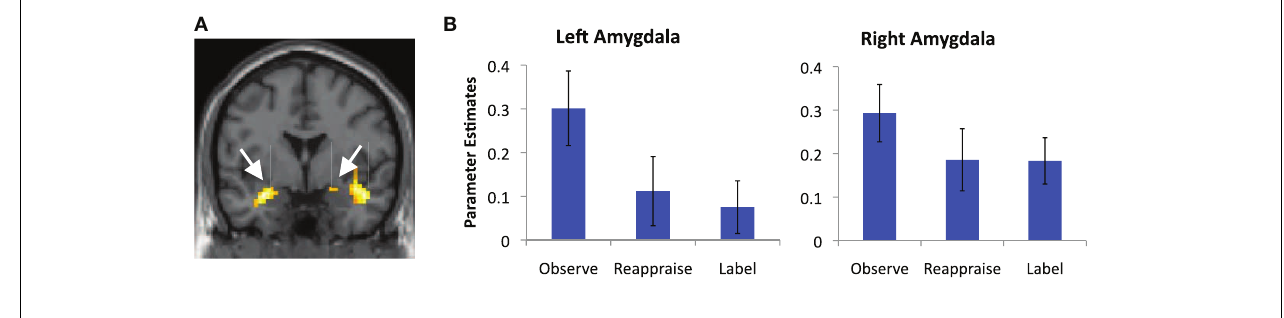
FIGURE 5 | Amygdala reductions. (A) Magnetic resonance image showing common regions of bilateral amygdala de-activation during affect labeling and reappraisal relative to passive observation; and (B) parameter estimates of activity extracted from the portion of these